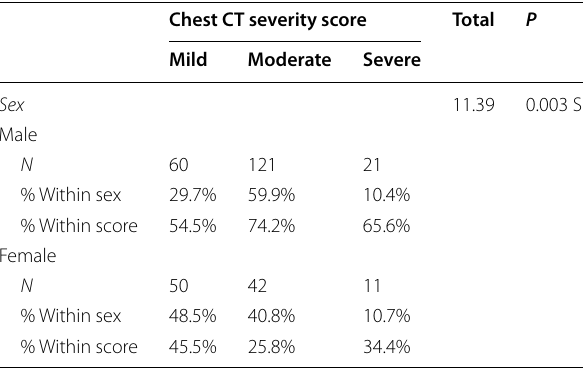
Table 4 Relation between chest CT severity score and gender